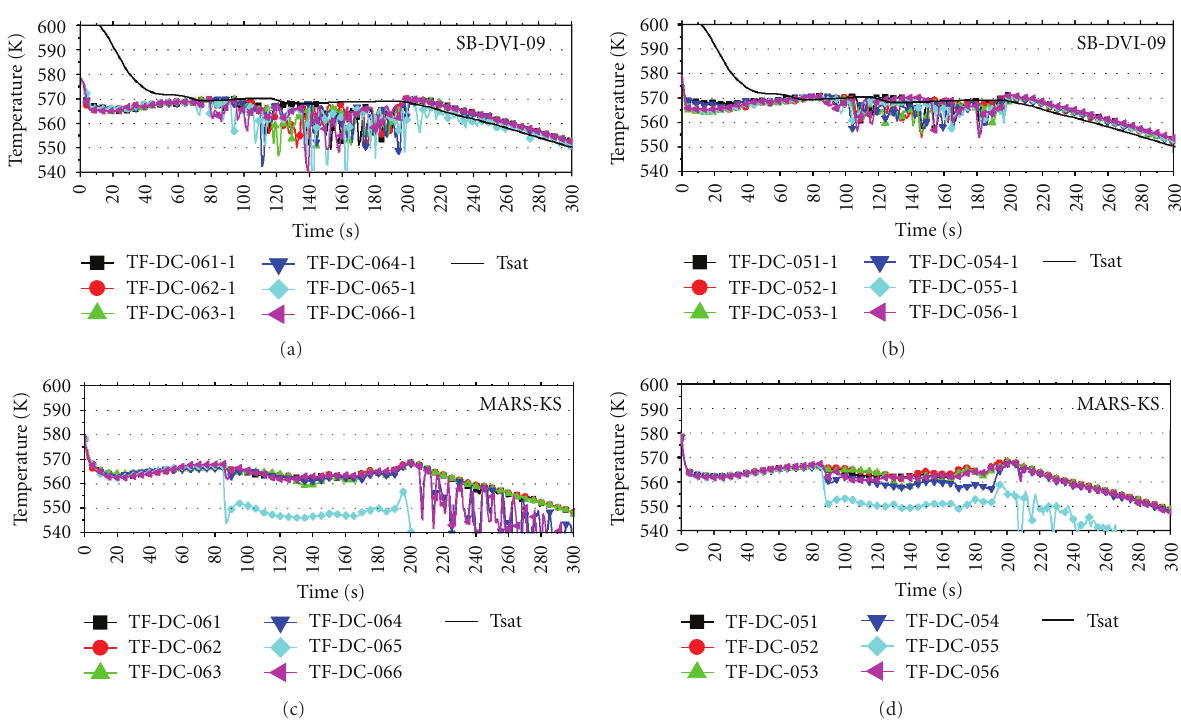
Figure 13: Comparison of upper downcomer fluid temperature with the measurement